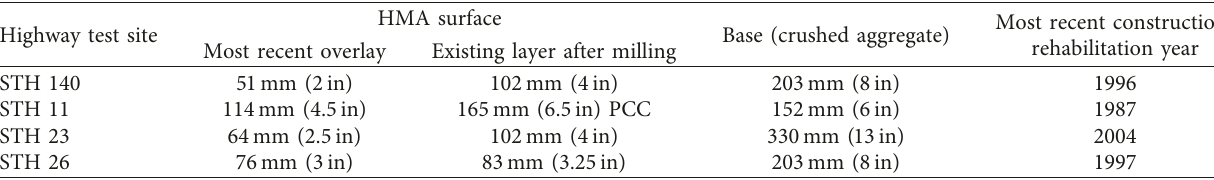
Table 2: Pavement structures at investigated highway test sites.